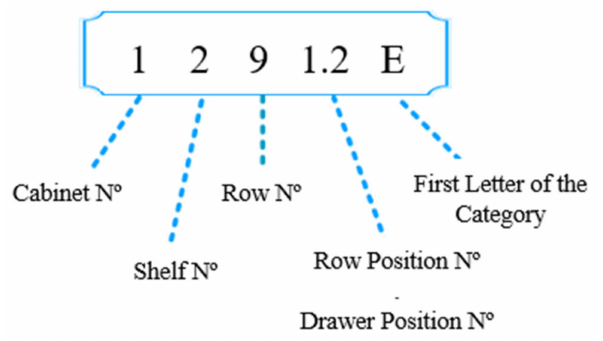
Figure 1. Coding proposed.